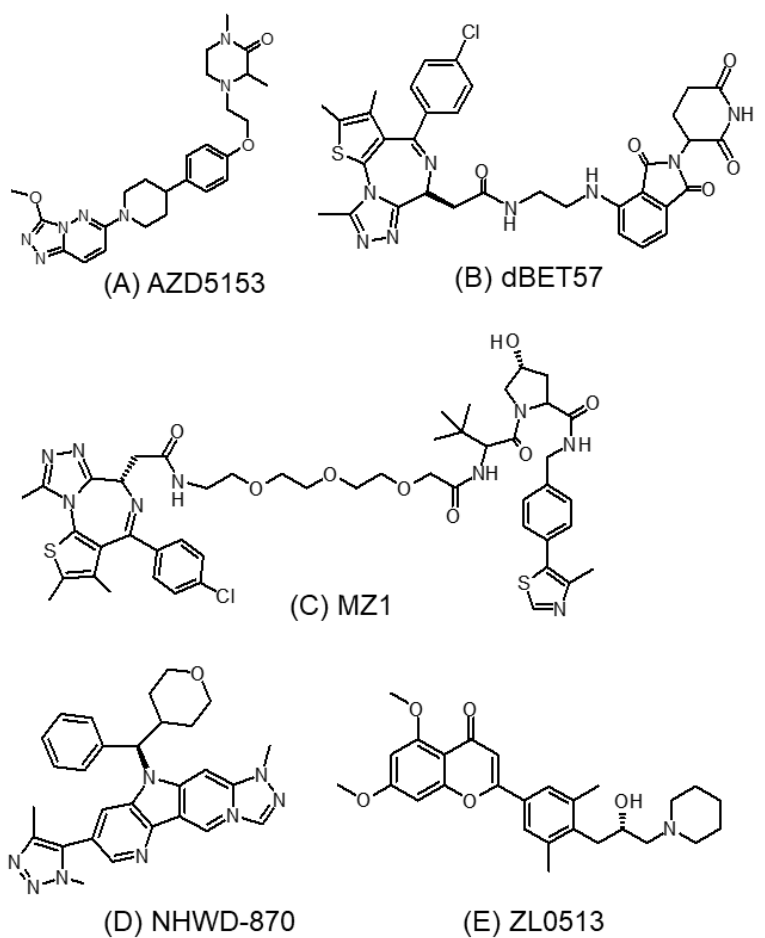
Figure 8. Chemical structures of the Brd4-selecitve BET inhibitors discussed: ( A ) AZD5153, ( B ) dBET57, ( C ) MZ1, ( D ) NHWD-870, and ( E ) ZL0513.